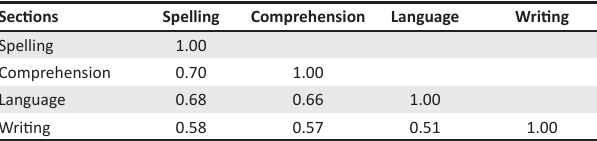
TABLE 3: Correlations between subtest scores. Sections Spelling Comprehension Language